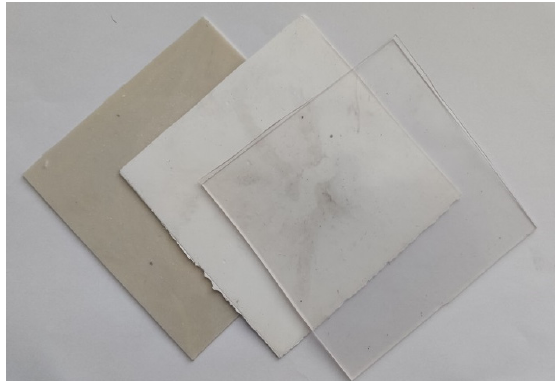
Figure 2. SEM pictures of the compounded material (from left: 34Ba, 20Bi, pure PVC).